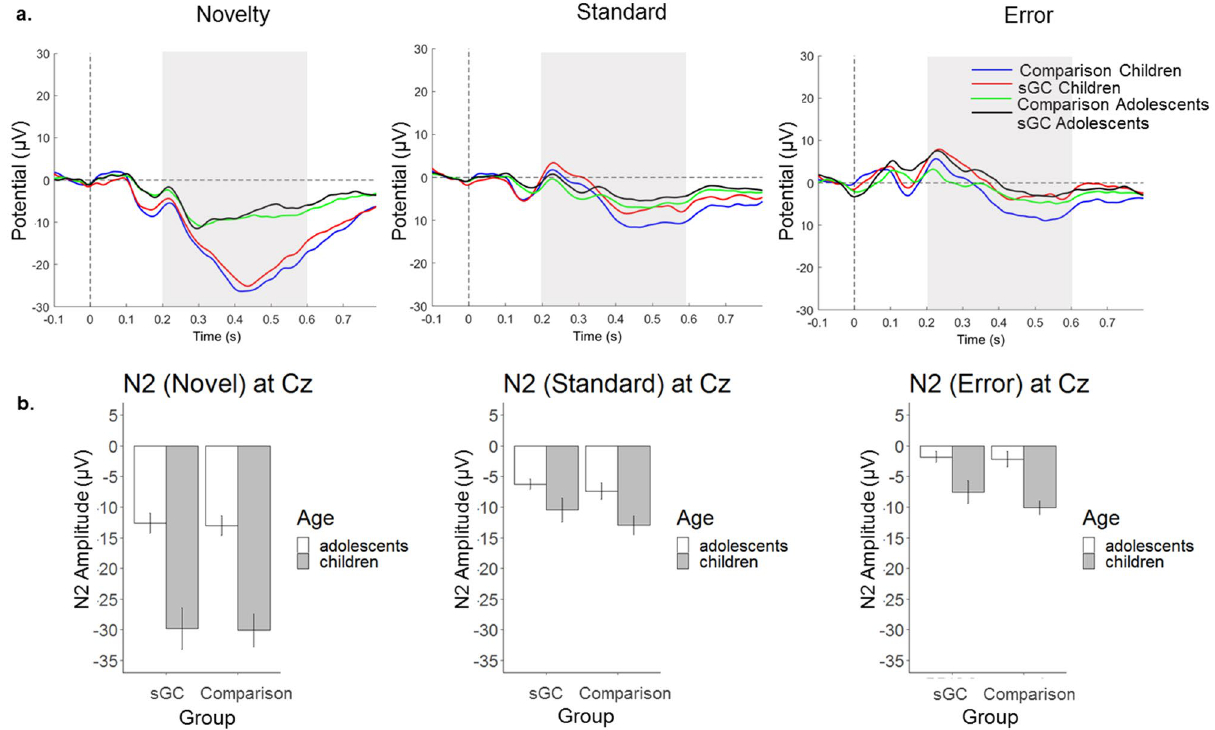
Figure 3. ( a ) Grand averaged ERP waveforms at Cz for Novel, Standard and Error stimuli; ( b ) Interaction between Age and Stimuli on N2 amplitude at Cz (Error bars represent ± 1 standard error of